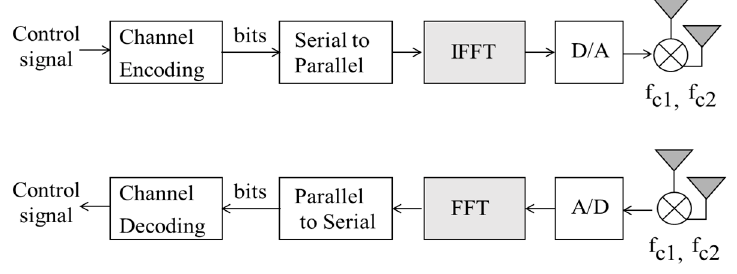
Figure 2. MIMO-OFDM block diagram.